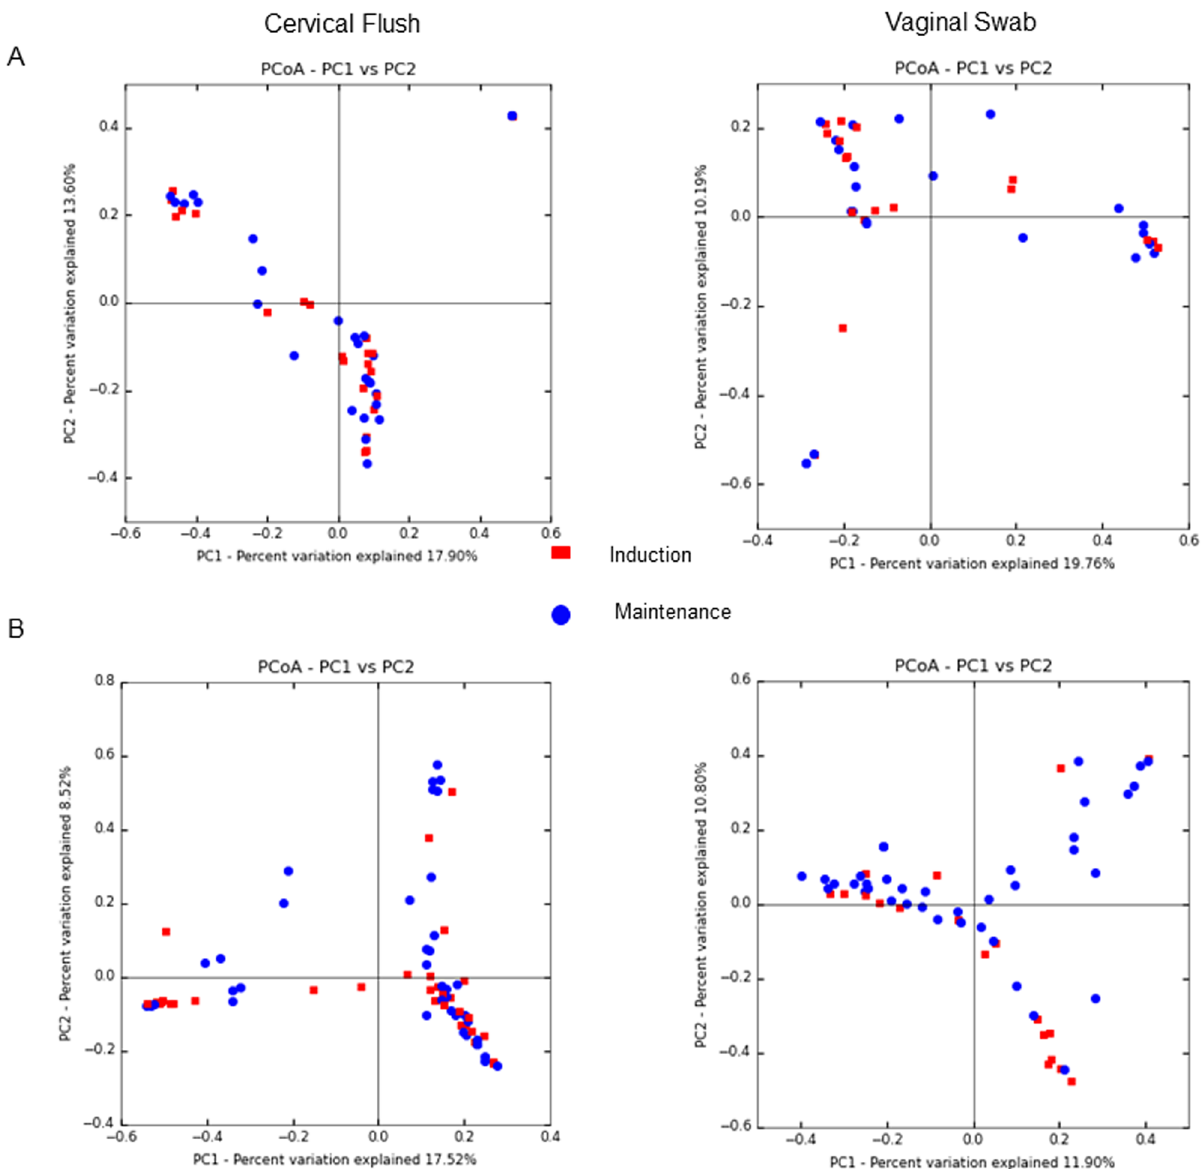
Fig 3. PCoA plots of distances between pig urogenital bacterial communities based on sample type and phase of diet study (A = lean and B = obese).